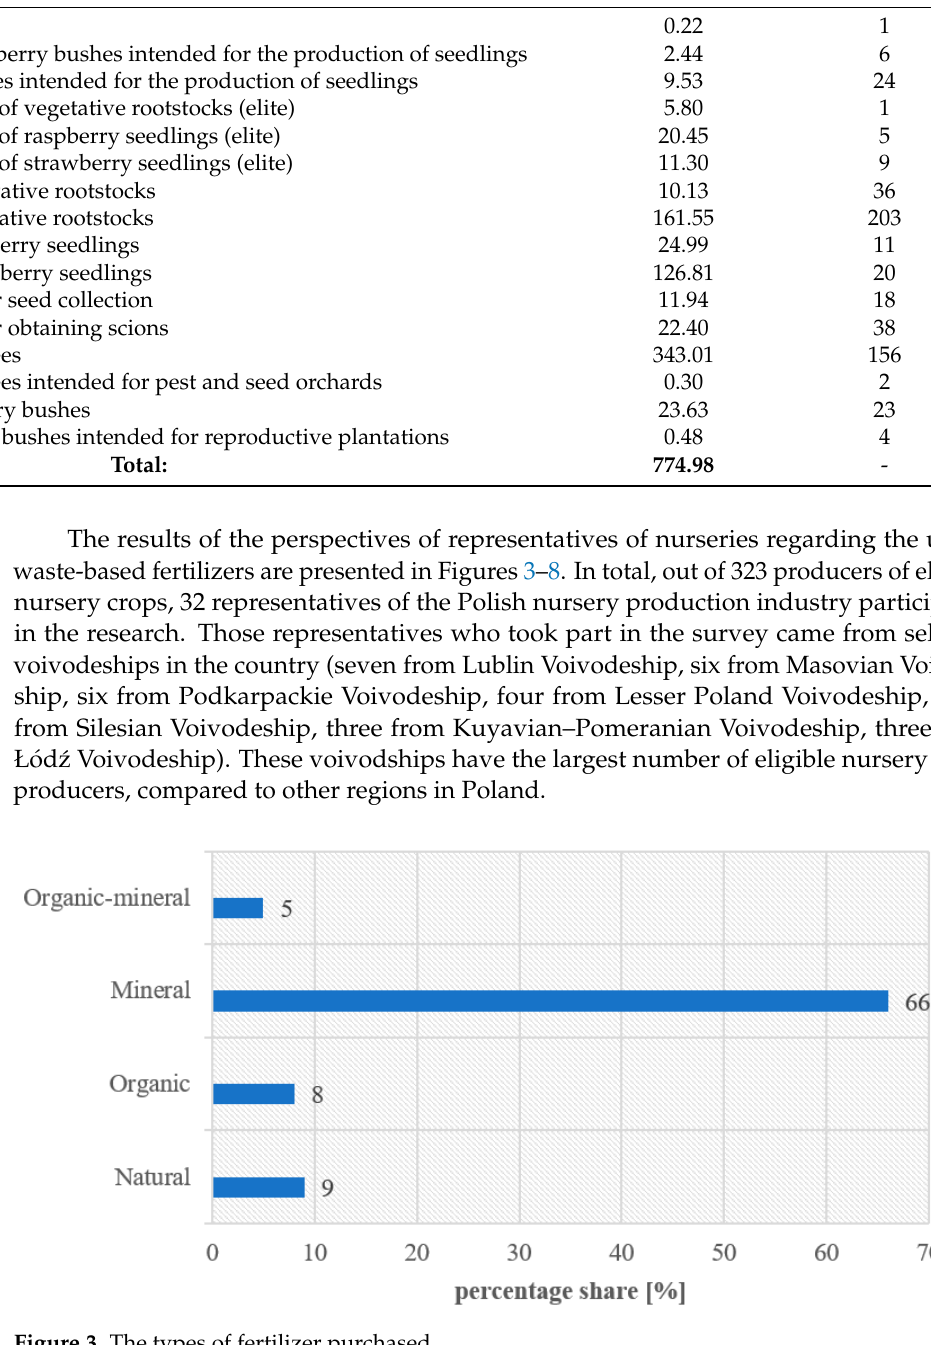
Figure 4. Frequency of purchase of fertilizers. Figure 5. Factors influencing the purchase of fertilizers.